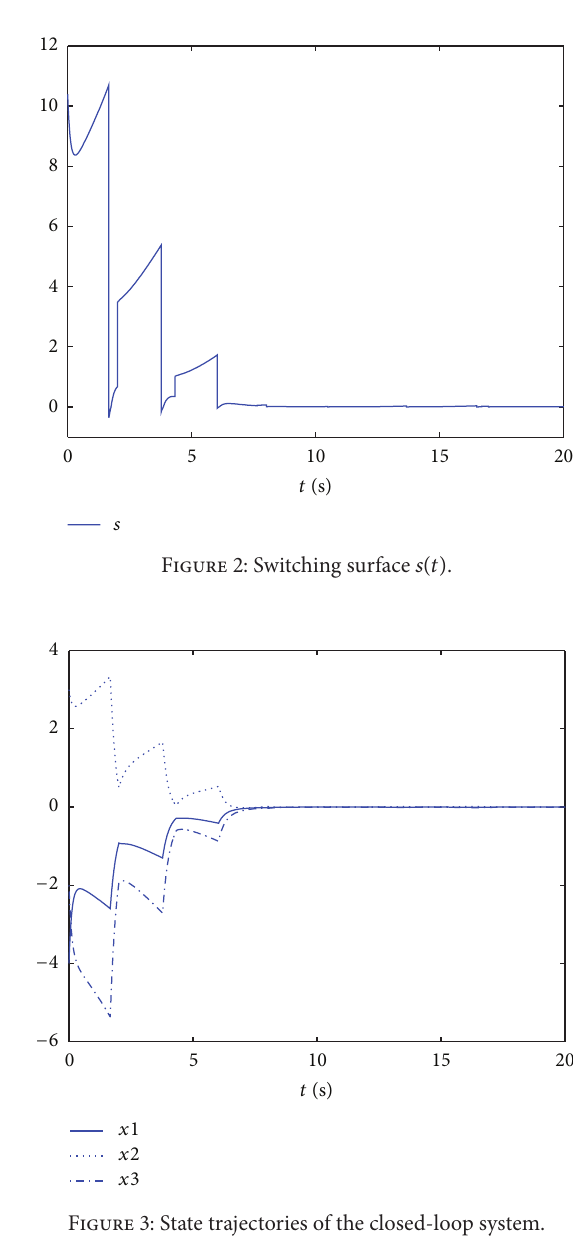
Figure 3: State trajectories of the closed-loop